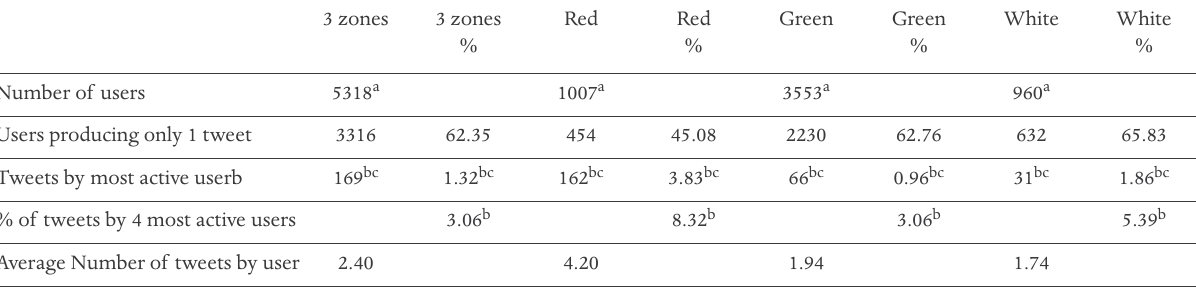
Table 3. The users. ( a ) Totals do not match, as some users have been localized in 2 different zones during the time span. ( b ) As @INGVter- remoti offers a professional information service (producing a disproportionately high amount of tweets), we have not included it here. ( c ) The most active user in the entire dataset produced 169 tweets: among them, 162 in the red zone (this qualifies him as the most active user both in the 3 zones and in the red zone); the most active user in the green zone produced 66 tweets; the most active user in the white zone produced 31 tweets.